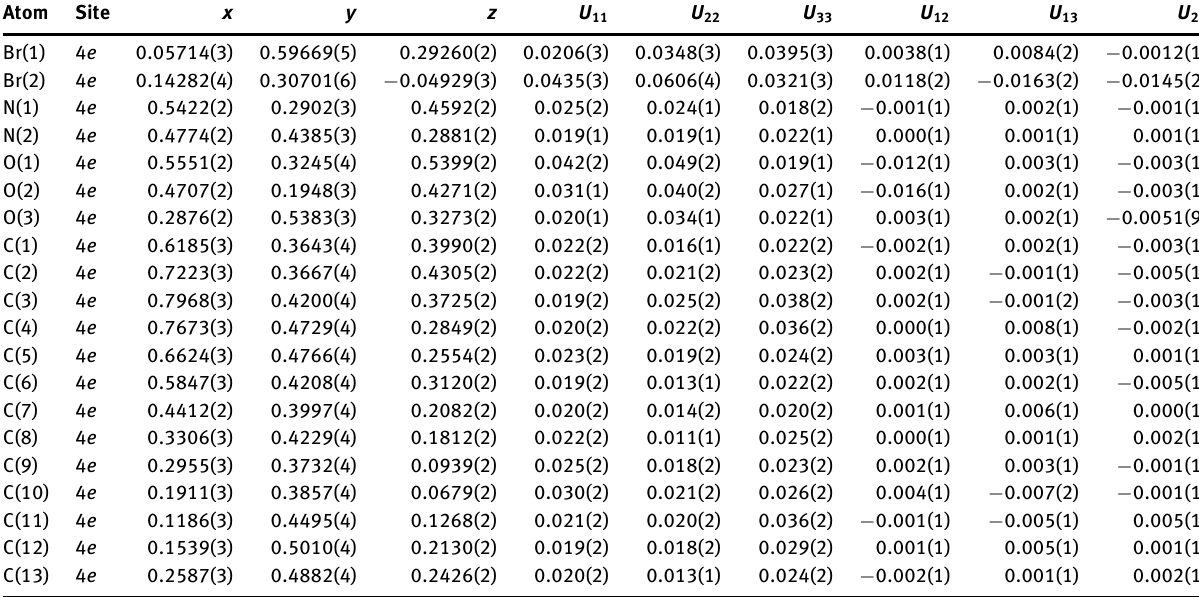
Table 3: Atomic displacement parameters (Å 2